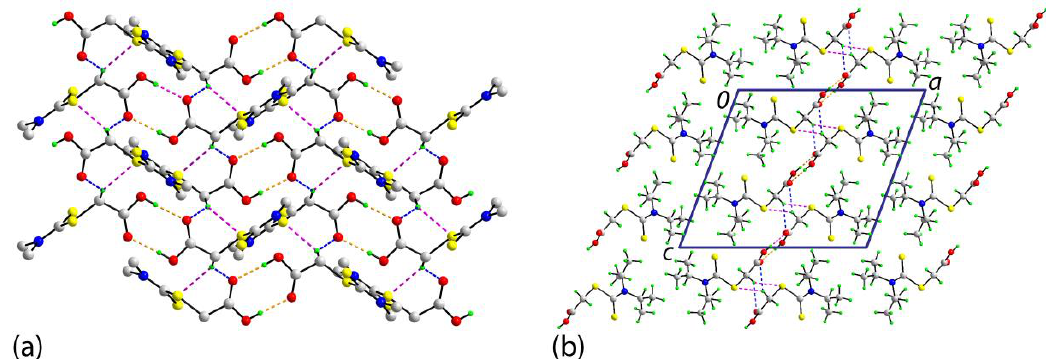
Figure 4. The molecular packing in the crystal of compound 1 : ( a ) A view of the supramolecular layer parallel to [1 0 1] sustained by hydroxyl-O-H ⋯ O(carbonyl) hydrogen bonding [O2-H2o ... O1 i : H2o ... O1 i = 1.85(3) Å , O2 ⋯ O1 i = 2.685(2) Å , and angle at H2o = 177(2)° for symmetry operation i: 1 − x , 1 − y , 1 − z ], methylene-C-H ⋯ O(carbonyl) [C2-H2b ⋯ O1 ii : H2b ⋯ O1 ii = 2.49 Å , C2 ⋯ O1 ii = 3.320(2) Å , and angle at H2b = 141° for ii: 1 − x , ½ + y , ½ − z ], and methylene-C-H ⋯ S(ester) [C2-H2b ⋯ S2 ii : H2b ⋯ S2 ii = 2.77 Å , C2 ⋯ S2 ii = 3.652(2) Å , and angle at H2b = 148°] interactions shown as orange, blue and pink dashed lines, respectively; non-participating hydrogen atoms and methyl groups have been omitted for reasons of clarity, and ( b ) a view of the unit cell contents shown in projection down the b -axis highlighting the inter-digitation of the layers shown in (a).